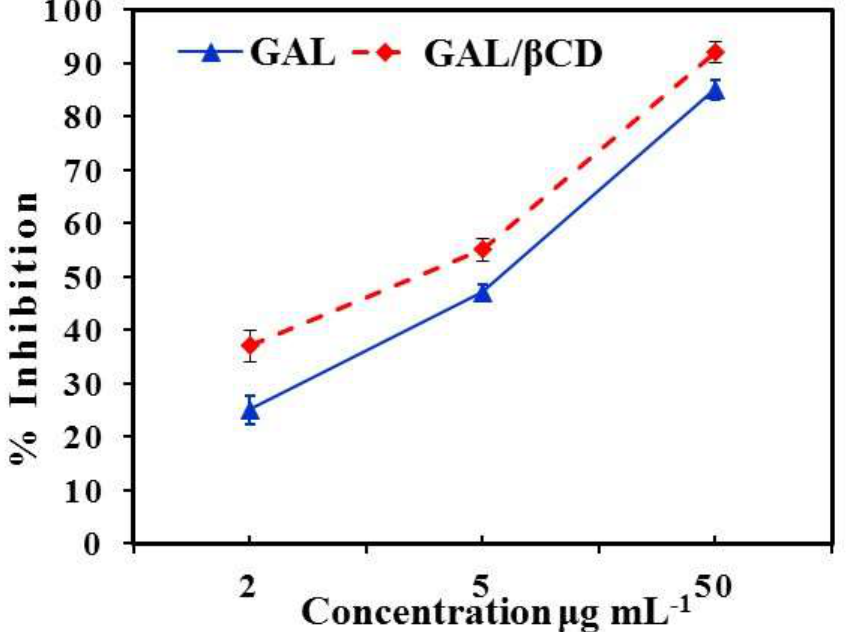
Figure 2: Antioxidant capacity against DPPH of pure galangin (Blue color) and galangin / β-cyclodextrin (Red color) using three different